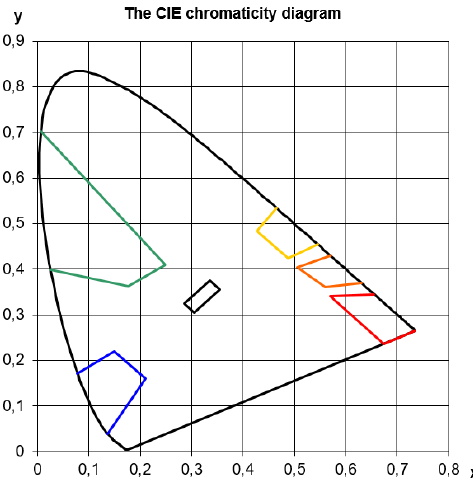
Figure 1. CIE color space with color boxes according to SS-EN 12899-1.